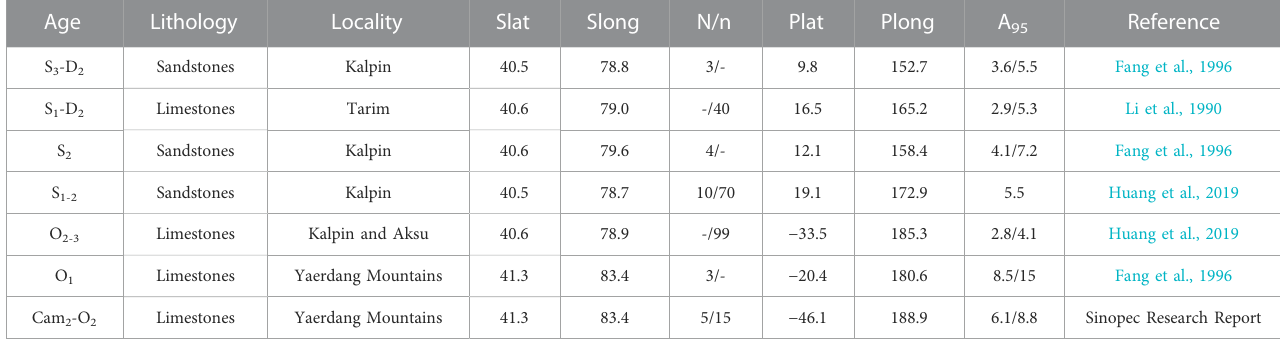
TABLE 1 Summary of available Early Paleozoic paleomagnetic poles for the Tarim block. Slat = Sampling locality Latitude; SLong = Sampling locality Longitude; N/n = Number of sites/number of samples;Plat = Pole Latitude; Plong = Pole Longitude; A 95 = 95% con fi denceoval (ordp/dm,semiminorand major axes of 95% con fi dence ellipsoid). Cam, O, S, and D indicate the Cambrian, Ordovician, Silurian, and Devonian times with 1= Early, 2 = Middle, and 3 =